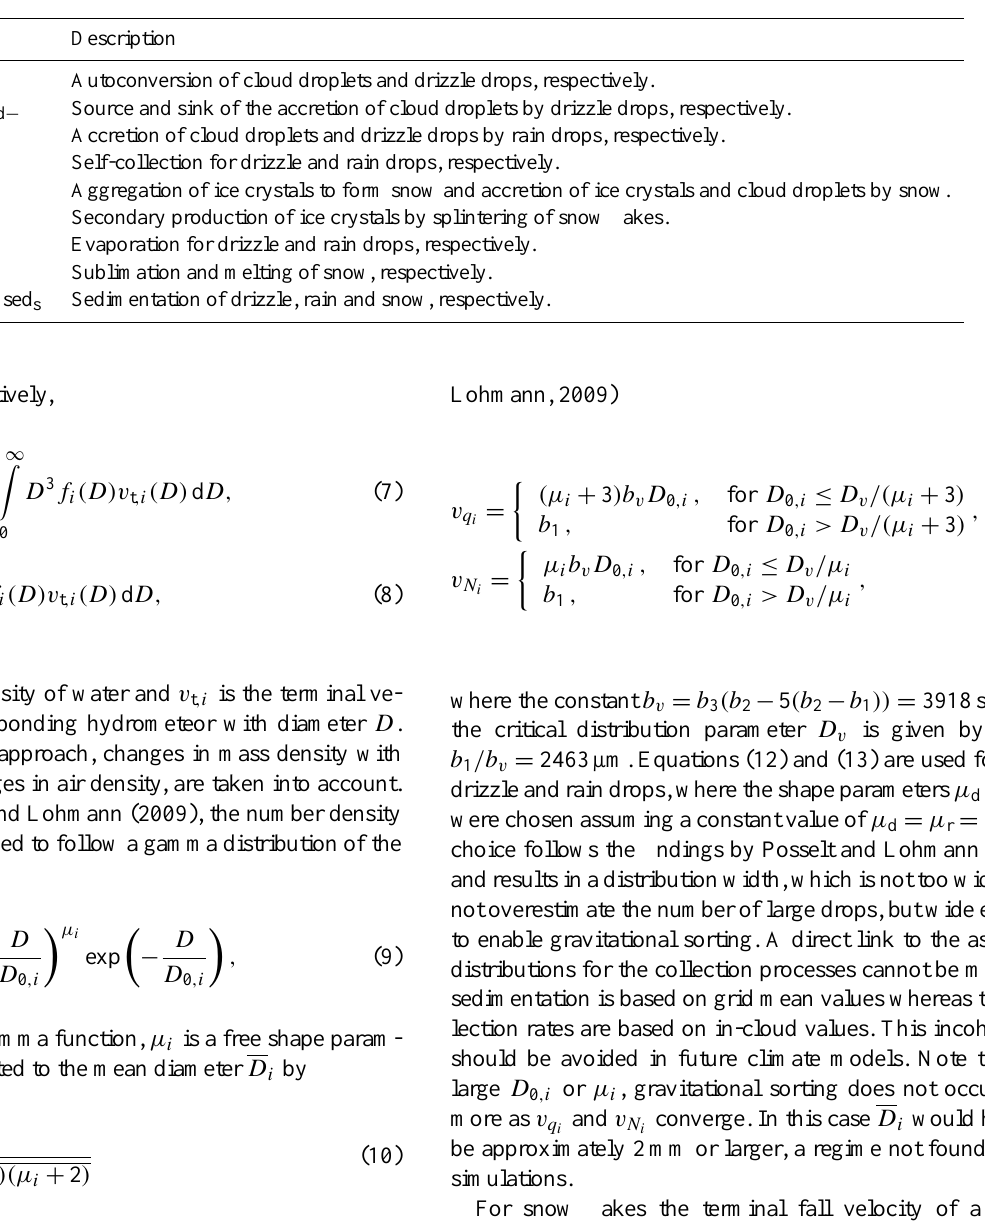
Table 1. Description of the different acronyms used in Eqs. (1)–(6) to describe the sinks and sources of the different